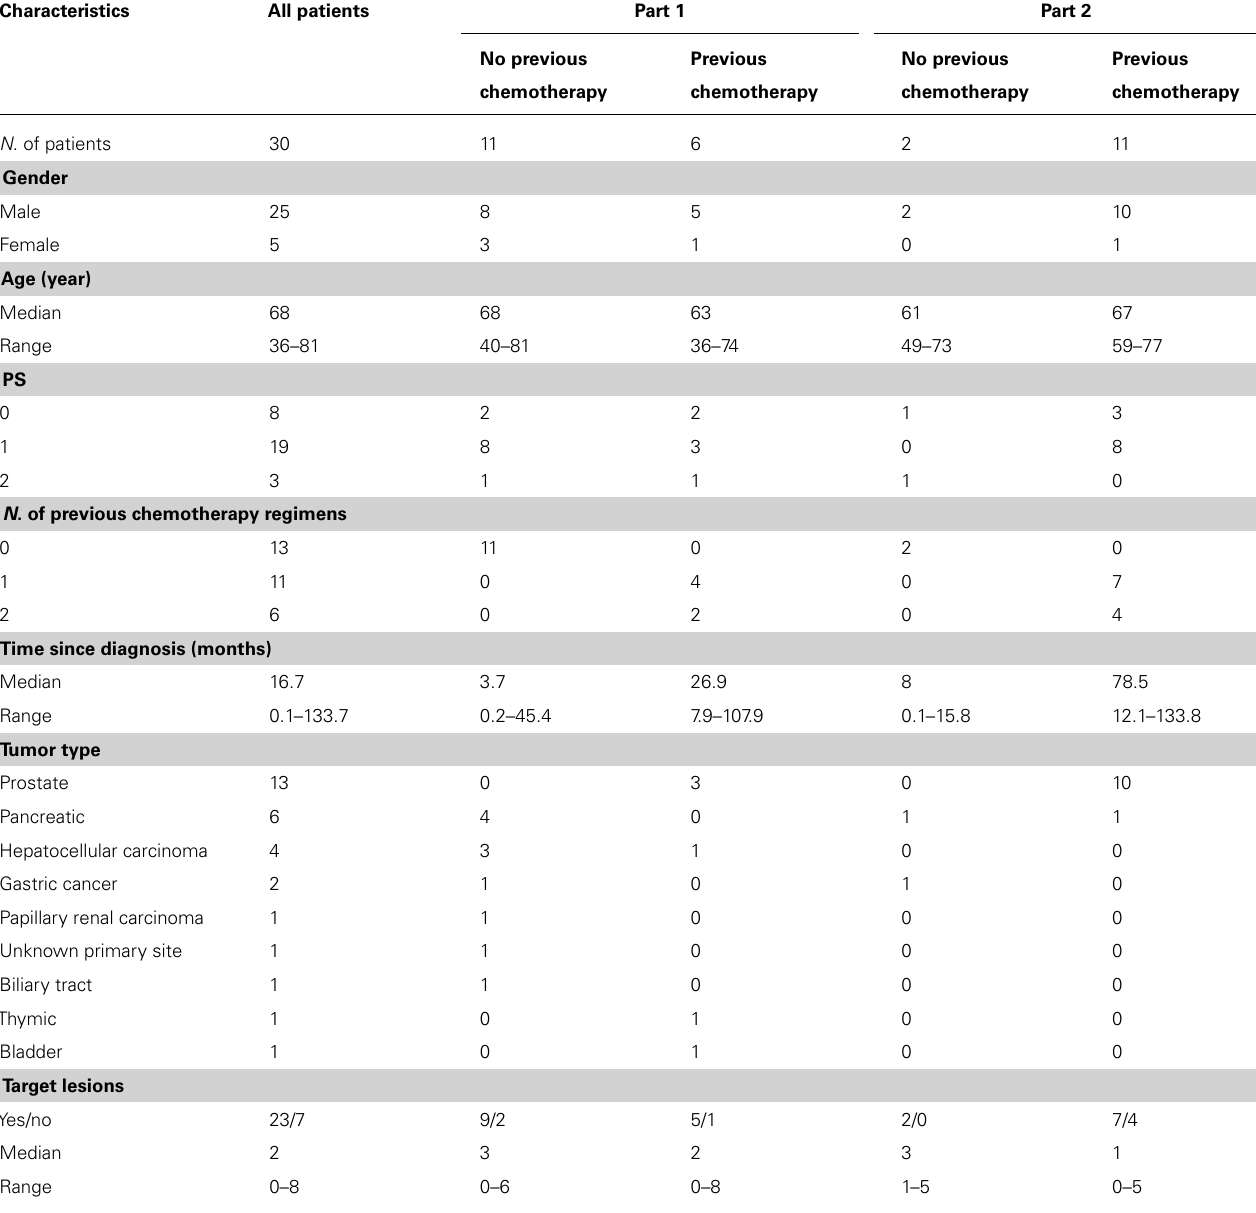
Table 3 | Patients